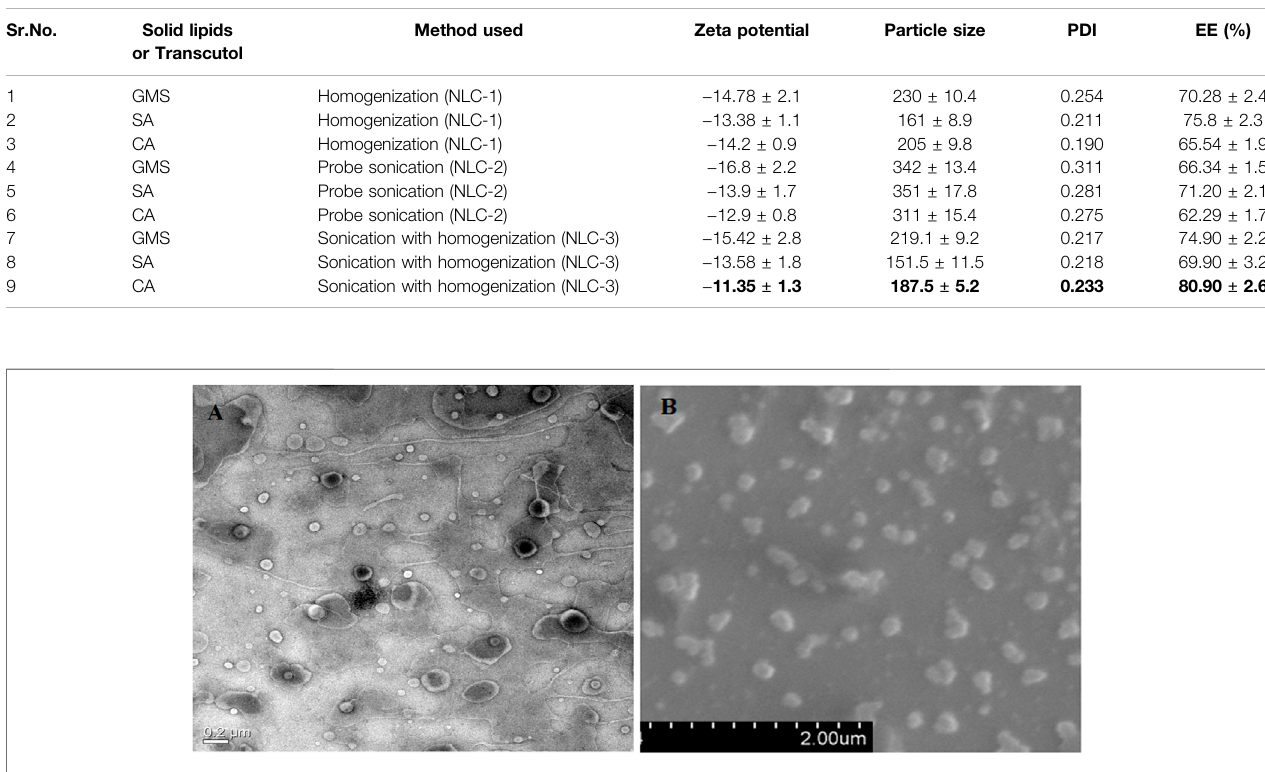
Frontiers in Pharmacology |